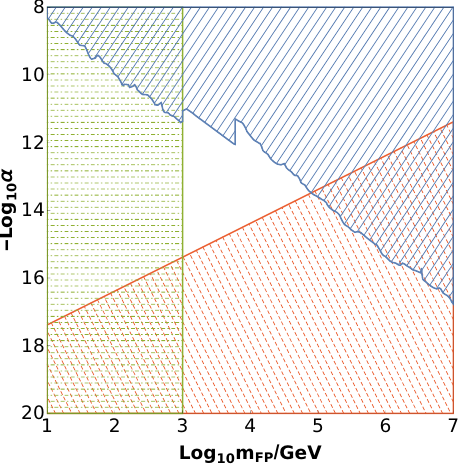
Figure 1. Available parameter space for heavy bimetric DM. The solid blue lines mark the region excluded by the strongest lifetime constraints; the dashed red lines fill the region we cannot study perturbatively; finally, the dotted-dashed green lines delineate the range of masses for which the final abundance of DM produced in the early Universe cannot match the experimentally-observed